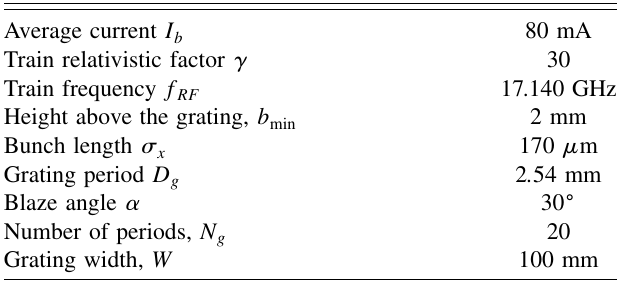
TABLE I. Smith-Purcell experiment parameters Average current I